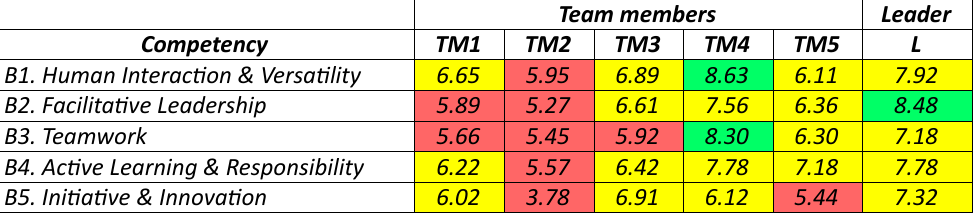
Table 3. Results of the competency evaluatons of a given team. Red indicates that the competency level is lower than 6; yellow indicates that the competency level is between 6 and 8.25, and green indicates that the competency level is higher than